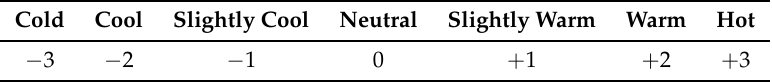
Table 1. The average human’s comfort degree on the 7-point ASHRAE scale. Cold Cool Slightly Cool Neutral Slightly Warm Warm Hot − 3 − 2 − 1 0 + 1 + 2 +